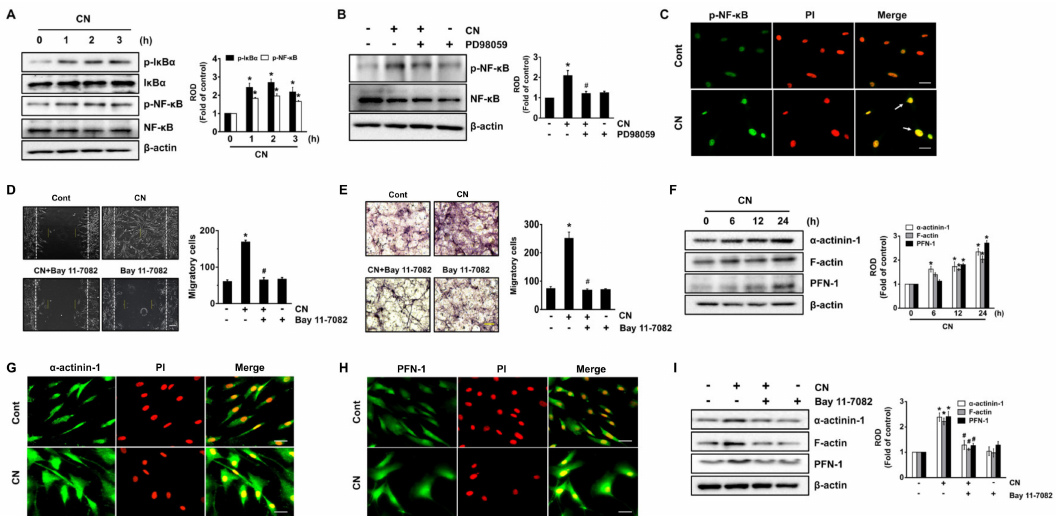
Figure 5. Regulatory e ff ect of CN on the activation of NF- κ B and the cytoskeletal reorganization. ( A ) Time responses of phosphorylation of I κ B α and NF- κ B in cell treated with CN are shown. Phosphorylation of I κ B α and NF- κ B were determined by western blot. Data represent means ±